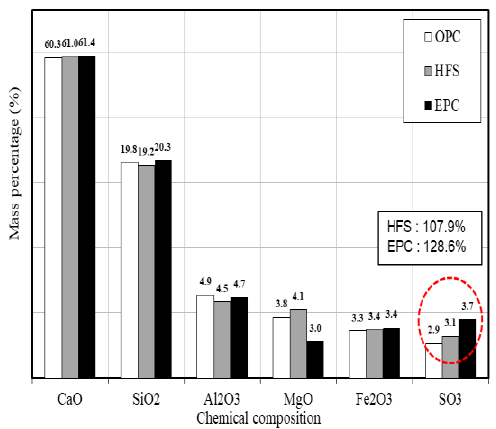
Figure 10. X-ray fluorescence (XRF) analysis results of OPC, HSPC, and EPC.